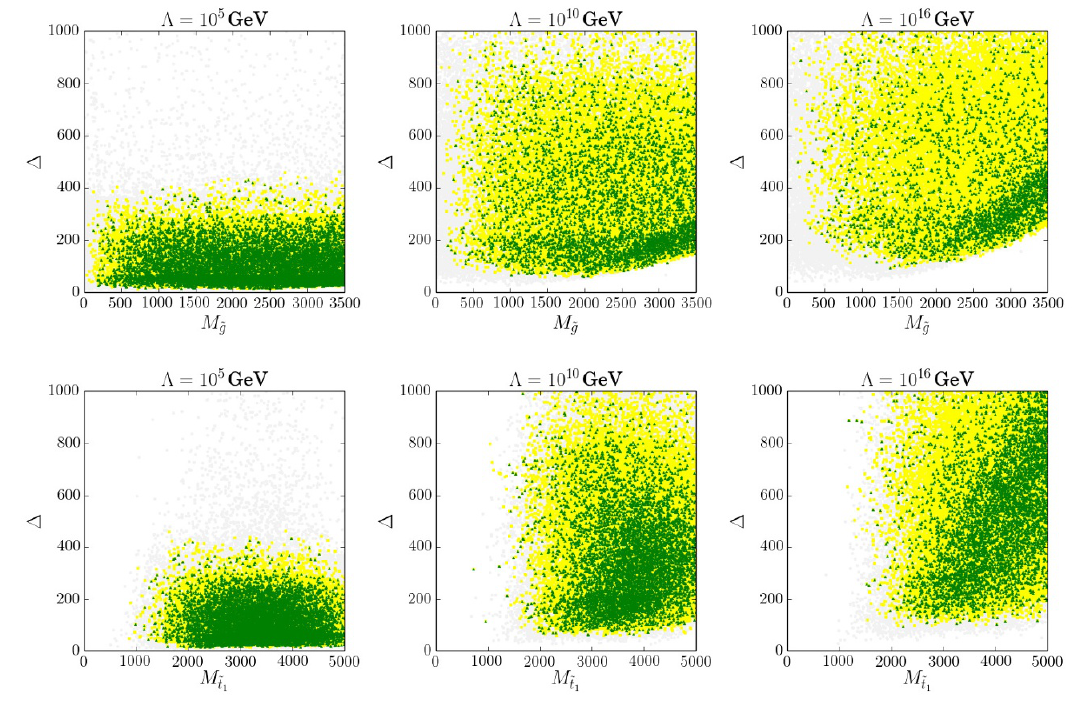
Figure 1 . Fine-tuning measure as a function of the gluino mass (top) and lighter stop mass (bottom) for three representative NP scales. Yellow squares contain LEP and Higgs mass constraints as well as B -Physics and Higgs precision constraints. The green triangles are a subset of these containing DM relic density and direct detection